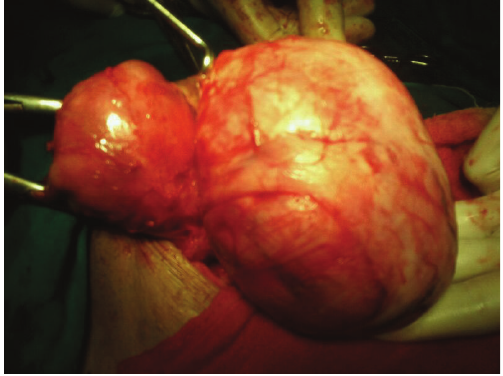
Figure 2: Hysterectomy and excision of retroperitoneal leiomyoma in progress.